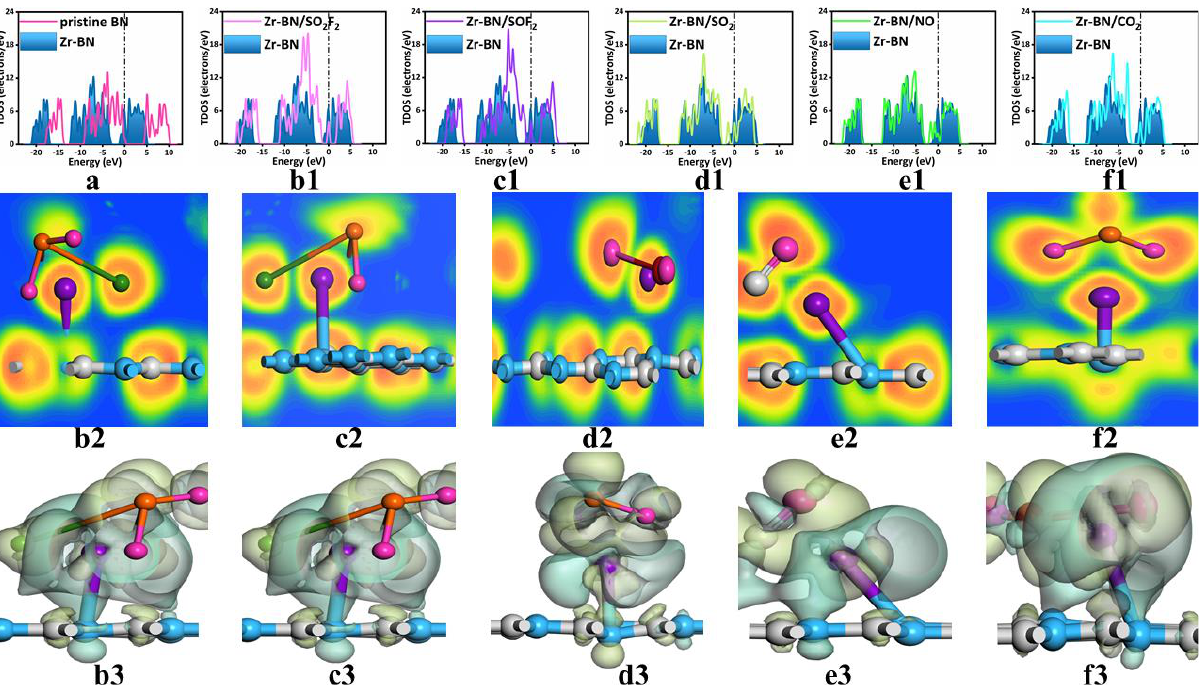
Figure 2. ( a ) The TDOS of h − BN monolayer and Zr − BN monolayer. The TDOS, ELF, and CDD of